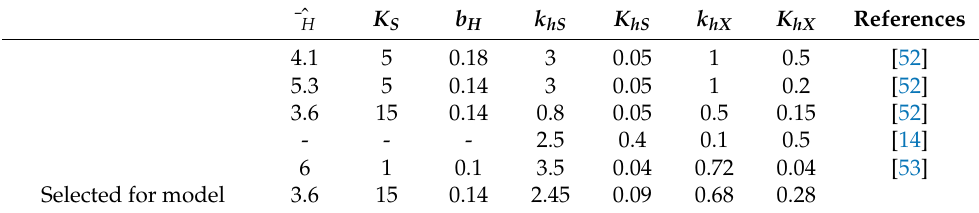
Table 3. Selected values of kinetic coefficients for textile